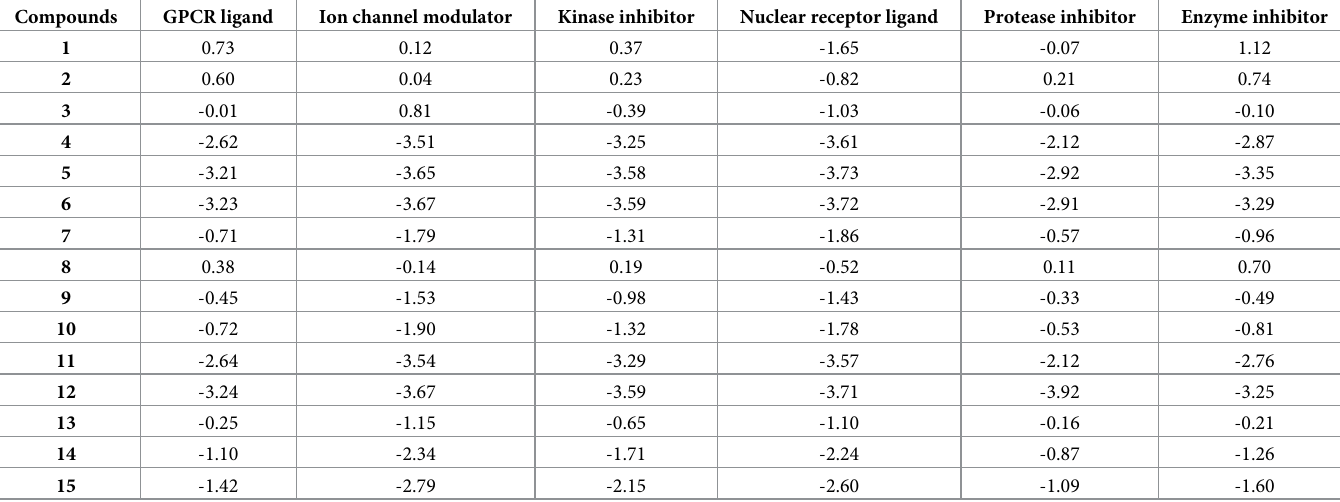
Table 4. Determination of drug-likeness score of cytidine derivatives through Molinspiration cheminformatics online server.